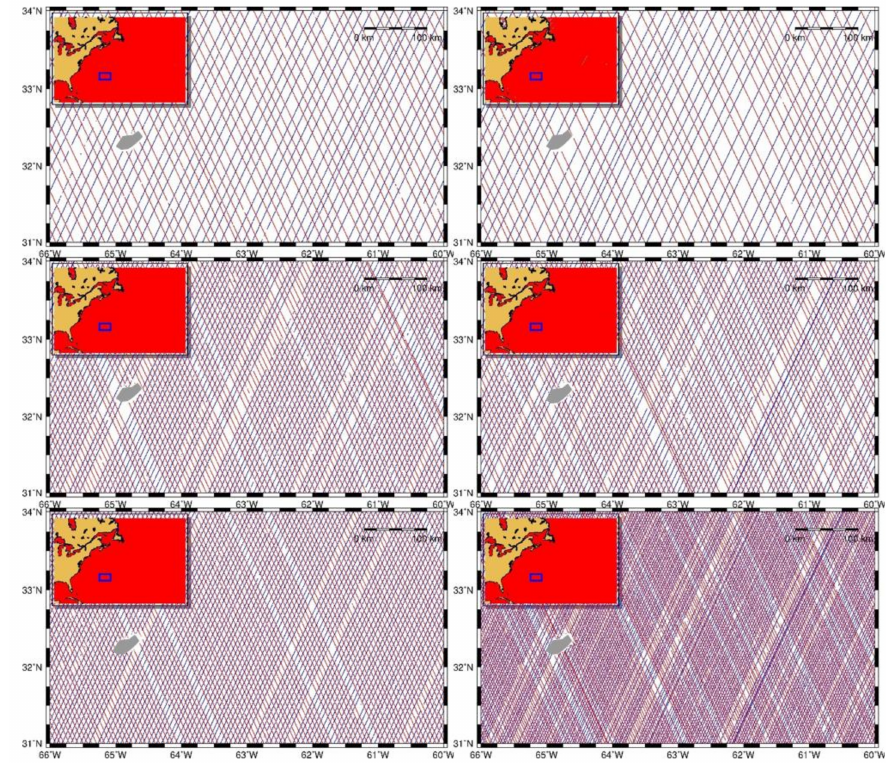
Figure 1. Geographic distribution of Jason Geodetic Mission (GM) altimeter measurements for a section in the NW Atlantic Ocean close to Bermuda (in grey). Upper left: J1 sub-cycle 1. Upper right: Jason 1 sub-cycle 2. Center left: J2 LRO Cycle 1. Center right: Jason 2 LRO cycle 2. Lower left: J1 Entire GM. Lower right: Jason 2 Entire GM (Both LRO